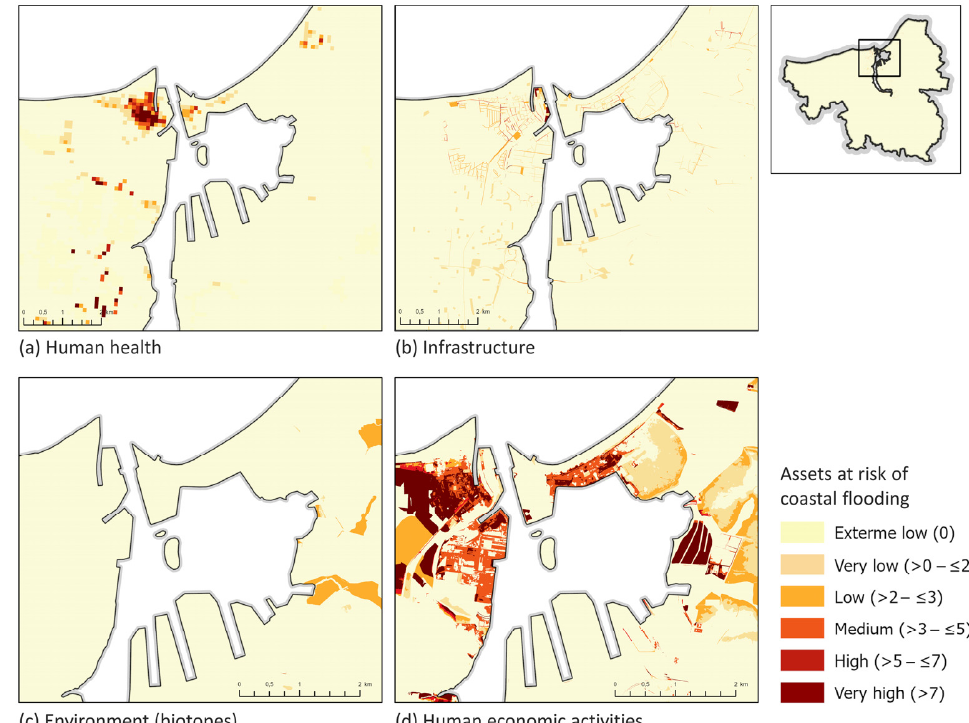
Figure 4. Spatial patterns of ES demand for coastal protection. The proxy indicators express coastal flood risks for different protected assets: ( a ) human health, ( b ) infrastructure, ( c ) environment (biotopes), and ( d ) human economic activities. The maps show the risks of a coastal flood event with a statistical 200-year recurrence interval in the harbour area of the city of Rostock.